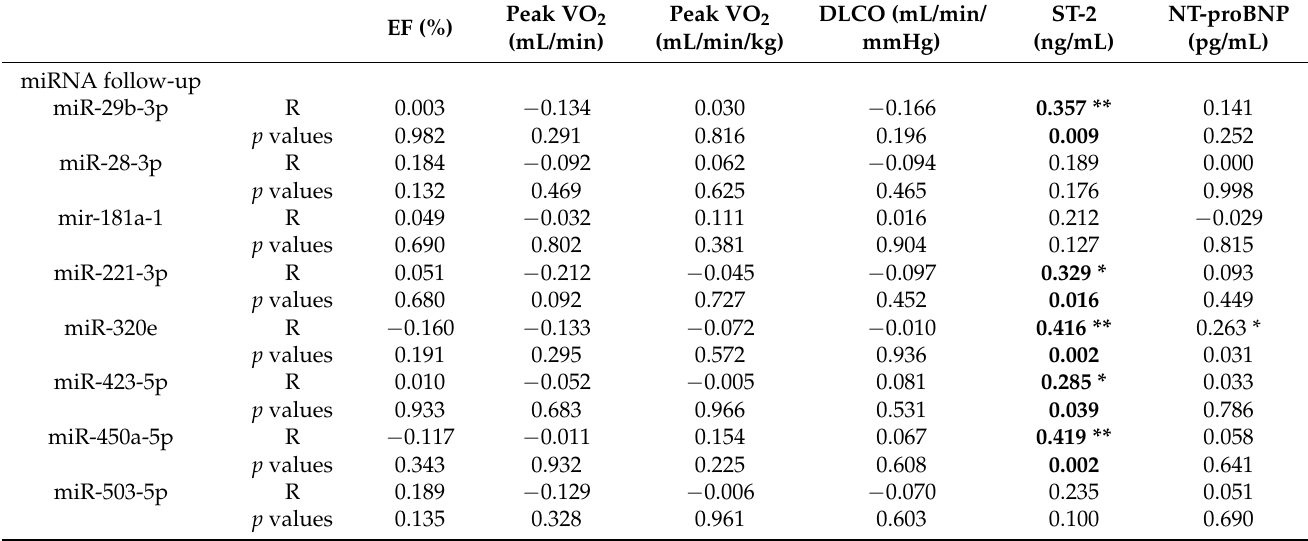
Table 4. Spearman’s correlation between levels of circulating miRNAs and clinical parameters at the follow-up.